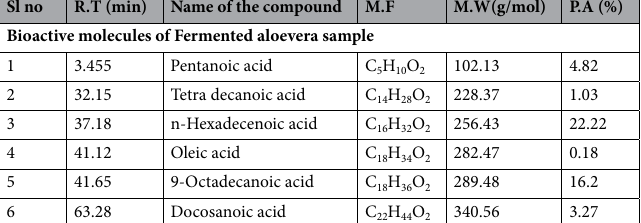
Sl no R.T (min) Name of the compound